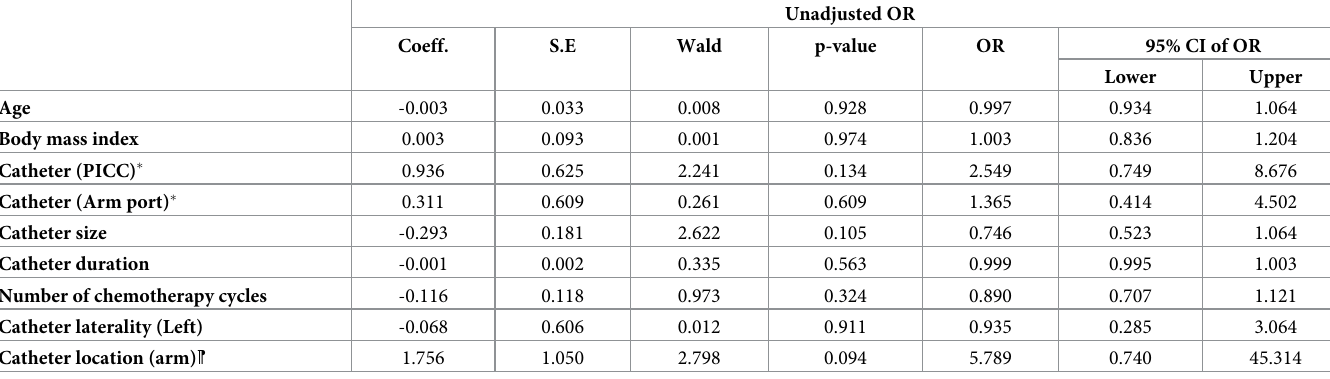
Table 3. Factors associated with catheter-related